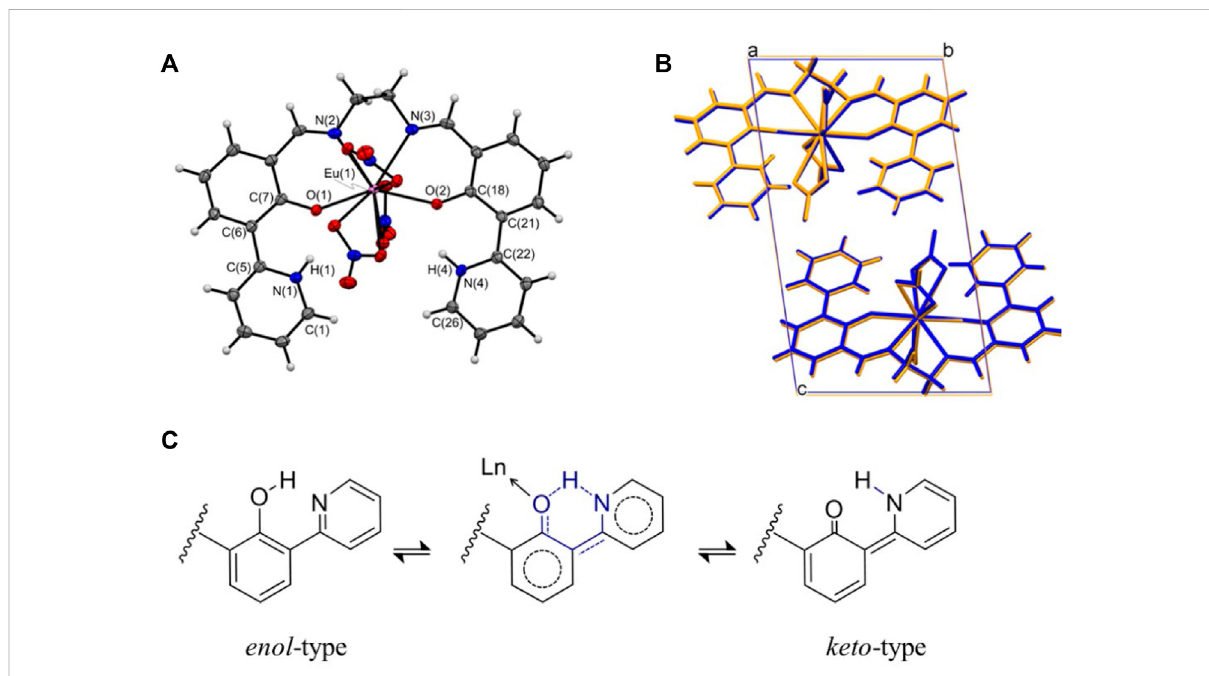
FIGURE 1 (A) ORTEP drawing of Eu L and (B) packing structures at 90 K (blue) and 300 K (orange) projected along the a- axis. (C) Possible enol – keto tautomerism and hydrogen-bonding in Ln L